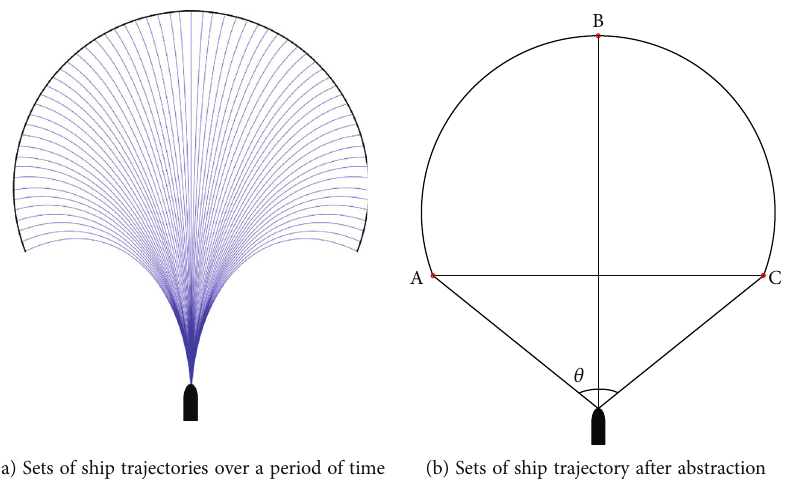
Figure 8: Sets of trajectories of the ship ’ s manoeuvring